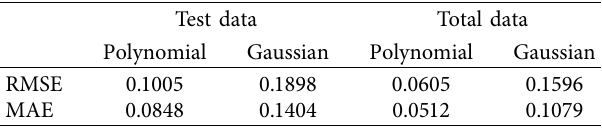
Table 10: Performance of the KSVR model for the estimation of ITS.